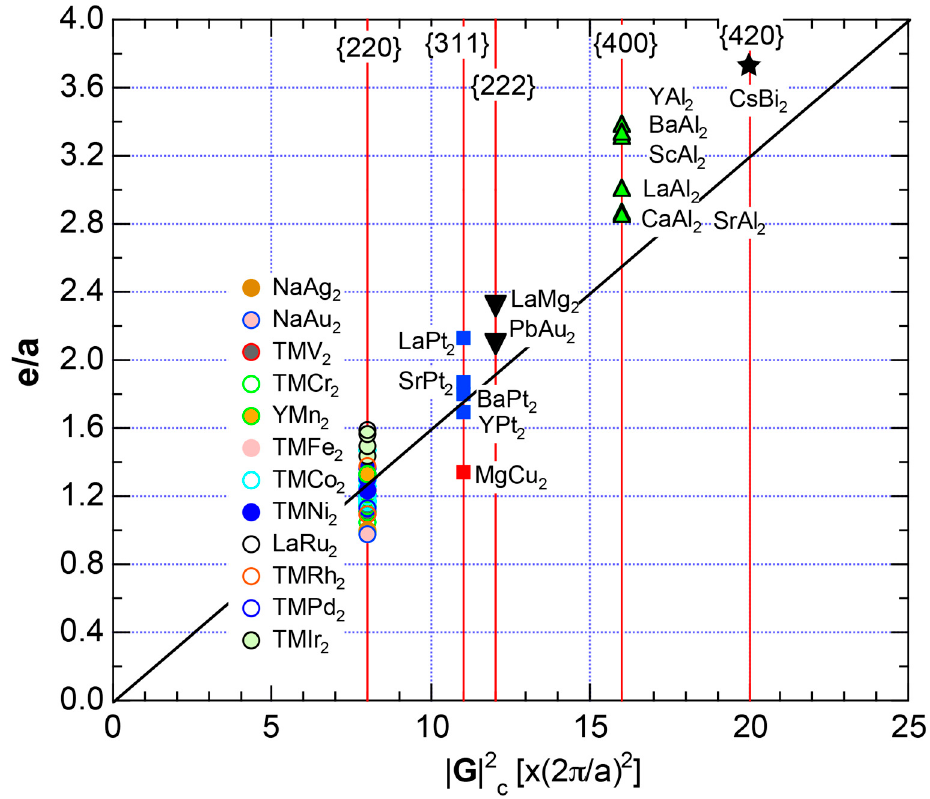
Figure 103. | G | 2 -dependence of e/a for Laves compounds (cF24) [37]. Three integers in the curly bracket indicate Miller indices of the set of lattice planes corresponding to | G | 2